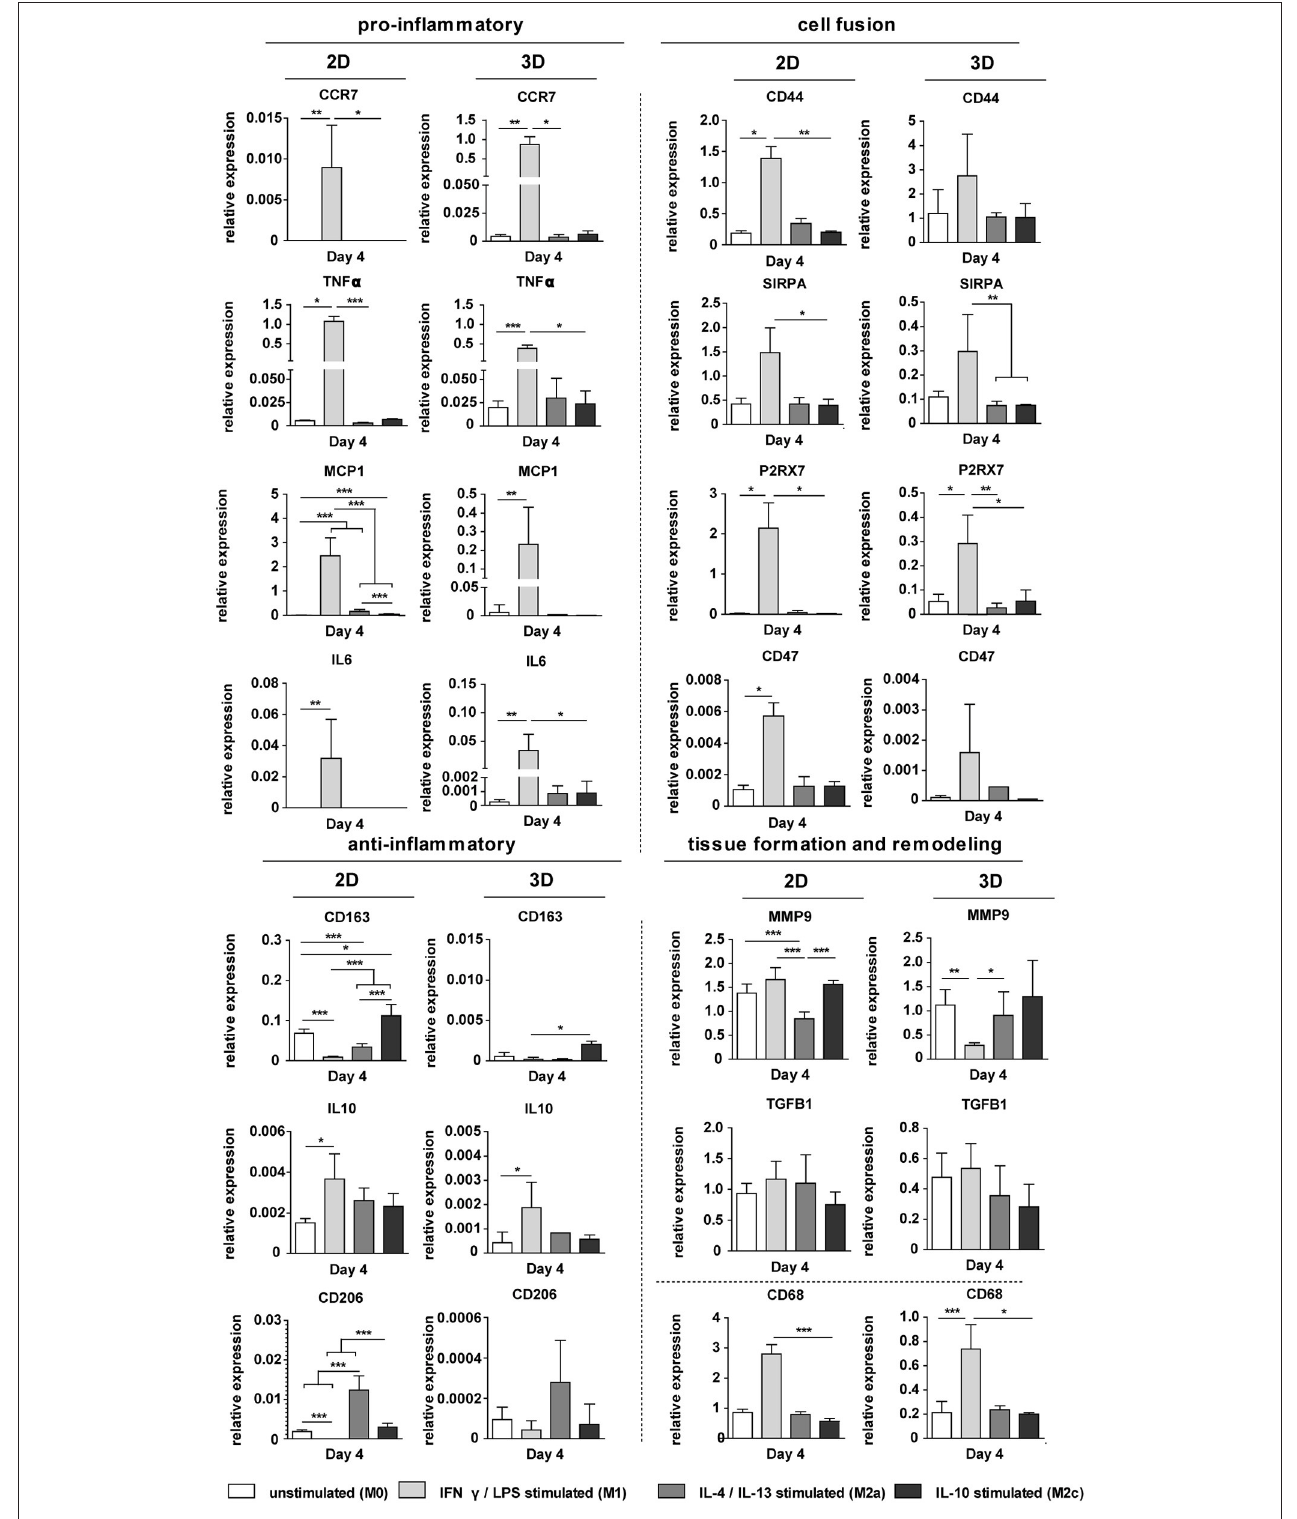
FIGURE 7 | Gene expression profiles in 2D and 3D. Relative expression of pro- and anti-inflammatory genes, ECM-related genes, and genes involved in cell fusion for biochemically stimulated macrophages cultured on polysterene (2D) or on 6 µ m fiber Ø isotropic scaffolds (3D) for 4 days. GAPDH was selected as the reference gene. * p < 0.05; ** p < 0.01; *** p < 0.001, N ≥ 6/group/time point.